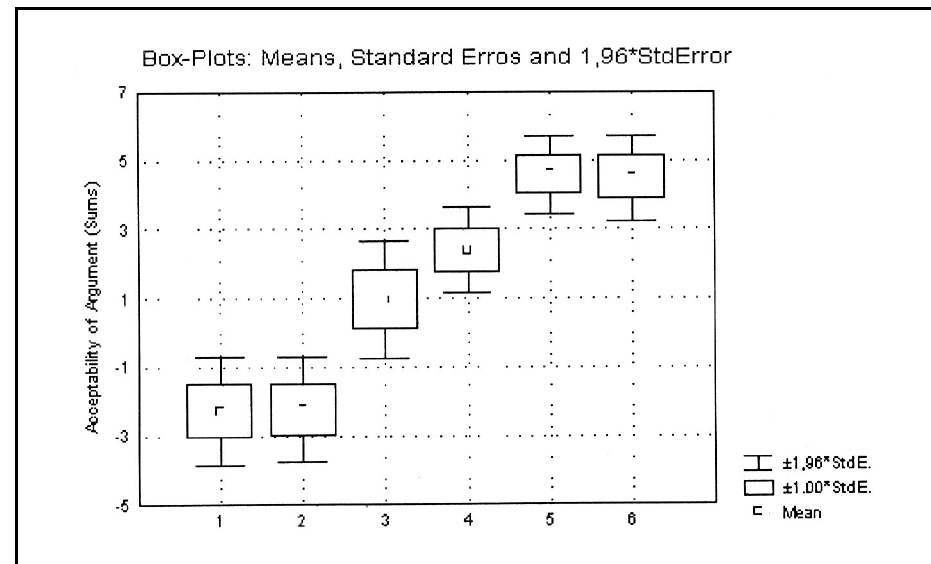
Figura 3 . Aceitabilidade dos argumentos – Médias e desvios padrão (Lind,